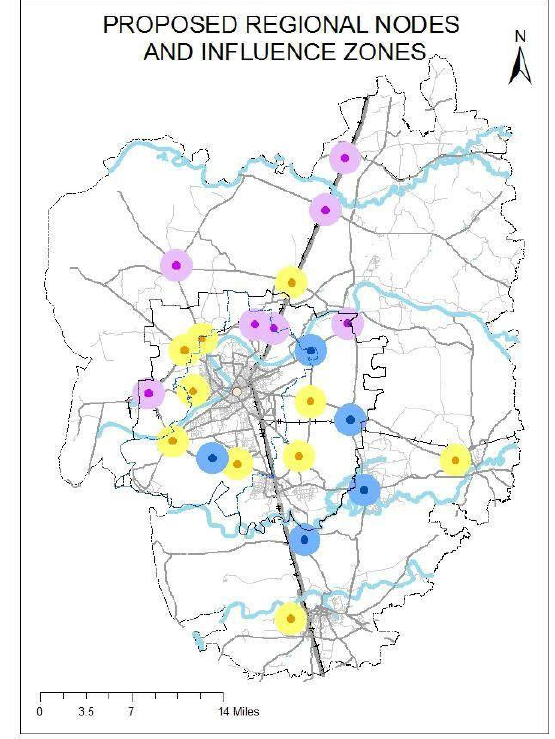
Figure 4: Proposed Regional Nodes with Governing Land Use